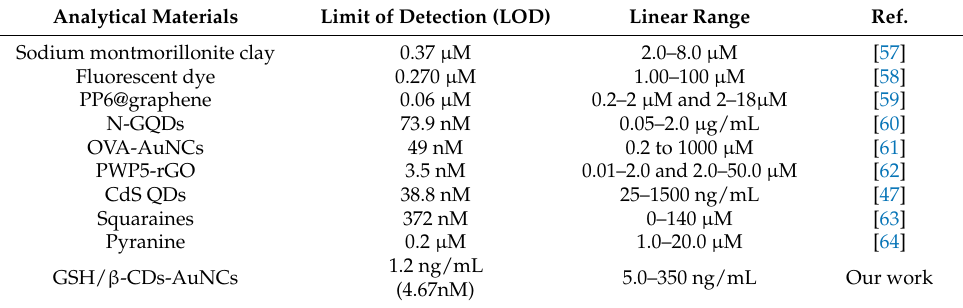
Figure 8. ( A ) Fluorescence spectra under various concentration of paraquat. The inset picture is the fluorescence photo showing the detection of various concentrations of paraquat with GSH/ β -CDs-AuNCs. ( B ) Calibration curve of paraquat sensing with different concentrations of 0, 5, 10, 20, 50, 100, 150, 200, 250, 300, 350, 400, 450, and 500 ng/mL, respectively. The inset shows the two linear fitting curves between the fluorescence-quenching efficiency [(F 0 − F 1 )/F 0 ] and the paraquat concentrations. Table 1. Comparison between our method and the reported fluorescence analysis methods of